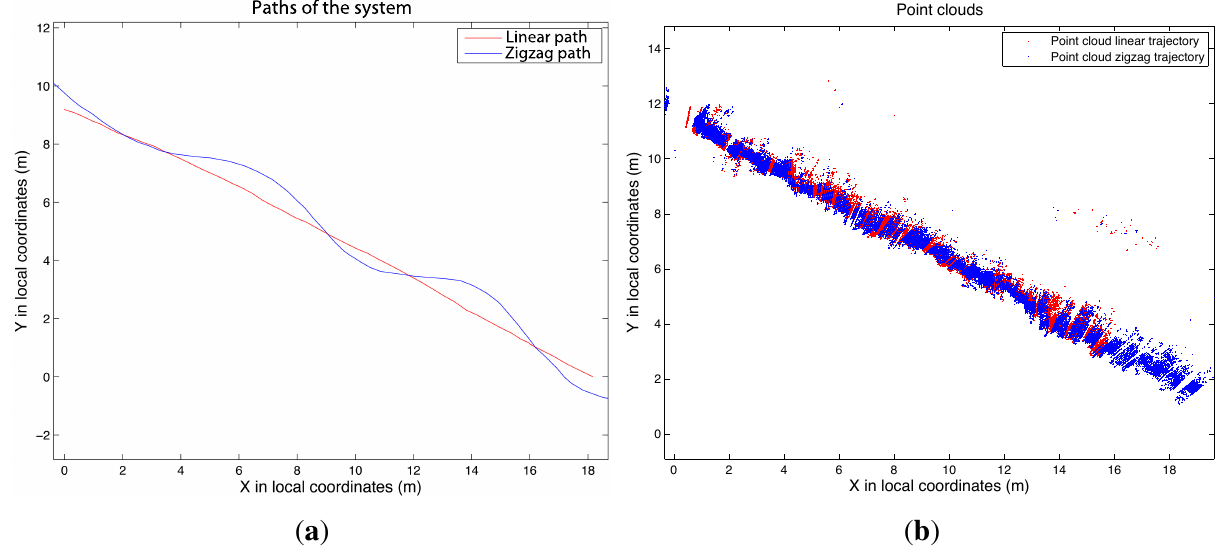
Figure 12. Zigzag path and linear path ( a ) and comparison between the respective point clouds ( b ).